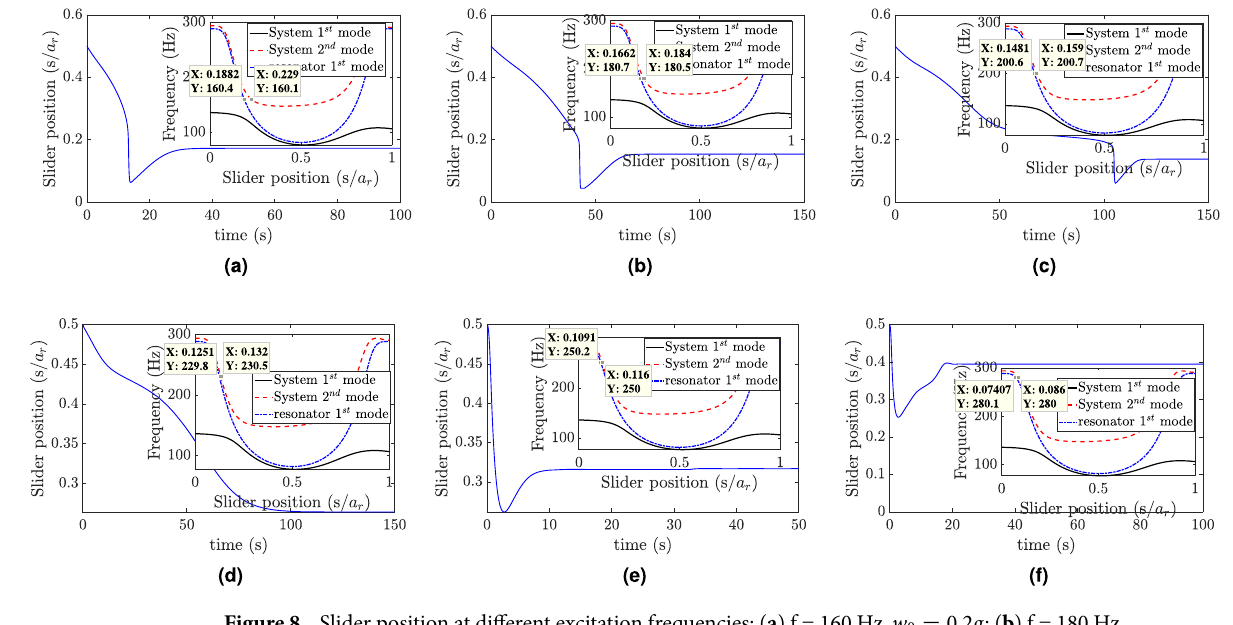
Figure 8. Slider position at different excitation frequencies: ( a ) f = 160 Hz, w 0 = 0.2 g ; ( b ) f = 180 Hz, w 0 = 0.3 g ; ( c ) f = 200 Hz, w 0 = 0.5 g ; ( d ) f = 230 Hz, w 0 = 0.8 g ; ( e ) f = 250 Hz, w 0 = 0.8 g ; ( f ) f = 280 Hz, w 0 = 0.8 g .